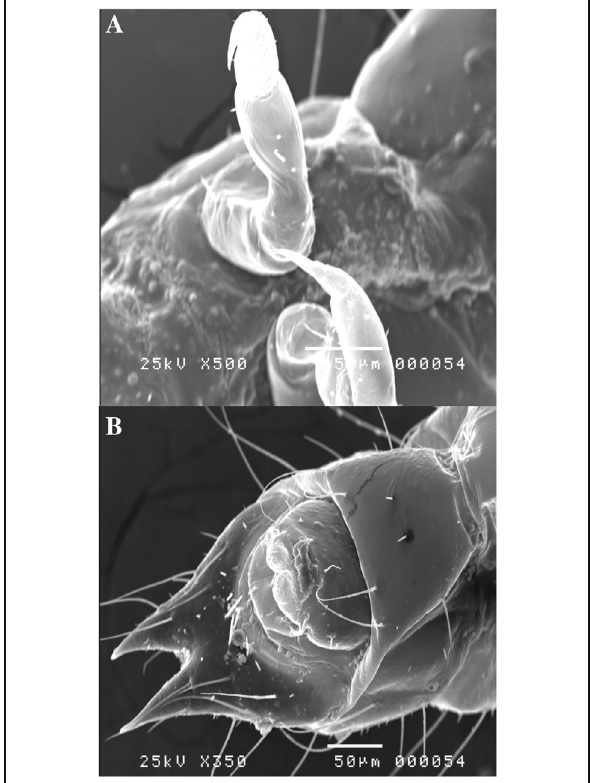
Fig. 9 a Higher magnification of the legs of the first larval instar of T. confusum . b Higher magnification of the last abdominal segments of the first larval instar of T. confusum